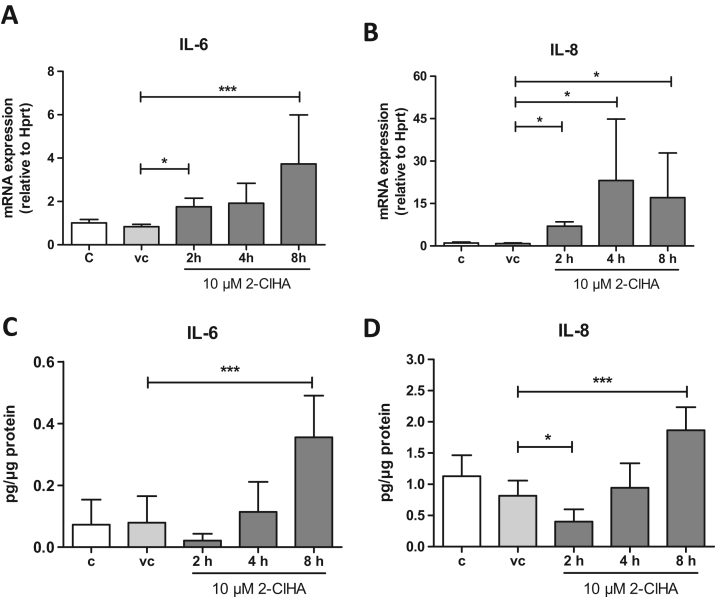
2-ClHA induces IL-6 and IL-8 gene and protein expression in hCMEC/D3 cells. (A,B) Serum-starved cells were incubated in the absence (c) or presence of DMSO (0.1%, vehicle control, vc) and 2-ClHA (10 μM) for the times indicated and gene expression of IL-6 (A) and IL-8 (B) was evaluated by qPCR analysis. Hprt was used as the housekeeping gene. Data shown are normalized to ‘vc’ and represent mean + SD from 3 independent experiments performed in triplicates. Expression profiles were calculated using the 2-ddCt method. (C,D) Cells were treated as in (A) and IL-6 (C) and IL-8 (D) concentrations were quantitated in the cellular supernatants by ELISA. Results shown represent mean + SD from three independent experiments performed in triplicate. *, p < 0.05; ***, p < 0.001; one-way ANOVA with Bonferroni correction.